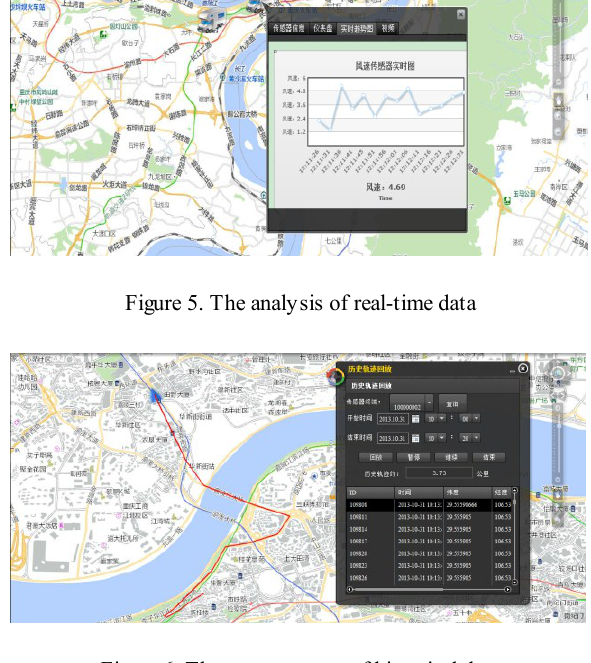
Figure 6. The reappearance of historical